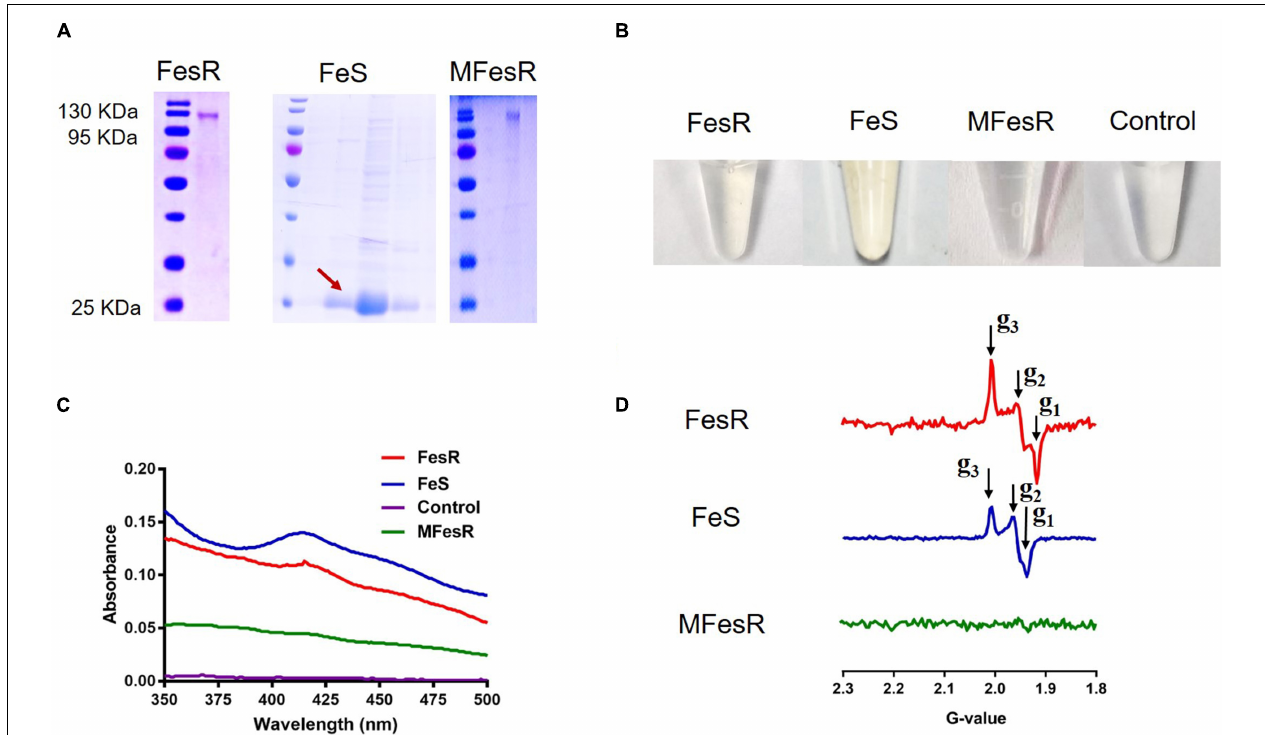
FIGURE 5 | The characteristics of FesR. (A) The purified FesR, Fe-S (only contain the 4Fe-4S binding domains) and MFesR (4Fe-4S cluster binding domains were mutant) were analyzed by SDS-PAGE. (B) The purified FesR, Fe-S and MFesR. (C) The UV-VIS spectrums of FesR, Fe-S, MFesR and Tris-HCl buffer (pH 8.0). (D) The EPR spectrums of FesR, Fe-S and